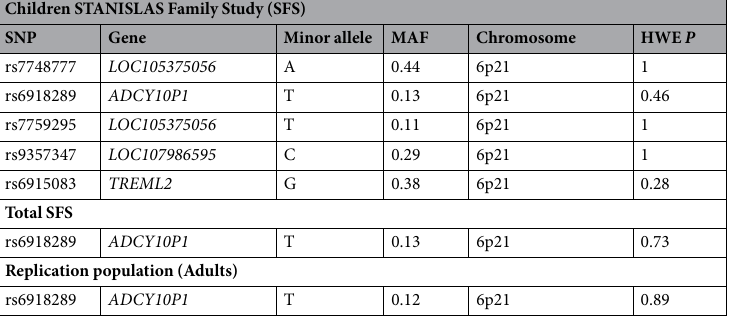
Table 2. Characteristics of the genotyped polymorphisms in TREM 2 region. With the exception of the SNP rs6918289, the rest were only genotyped in children.